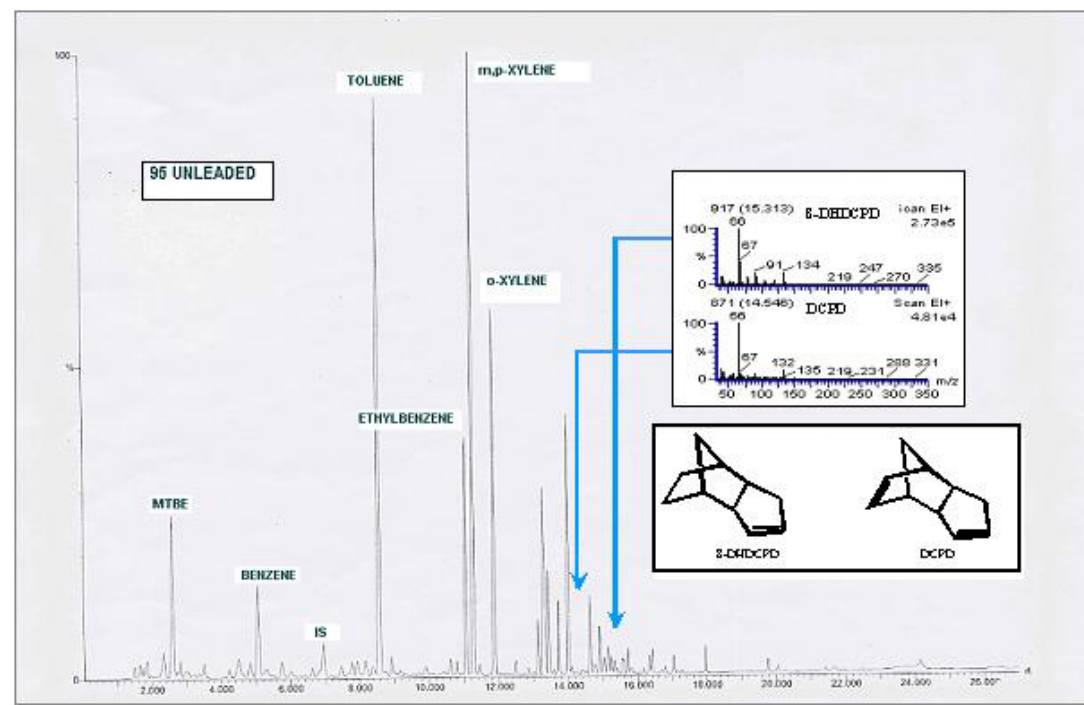
FIGURE 1. Chromatogram of 95–unleaded gasoline, showing the chemical structures of DCPD and 8-DHDCPD peaks and their mass spectra. (IS = Internal